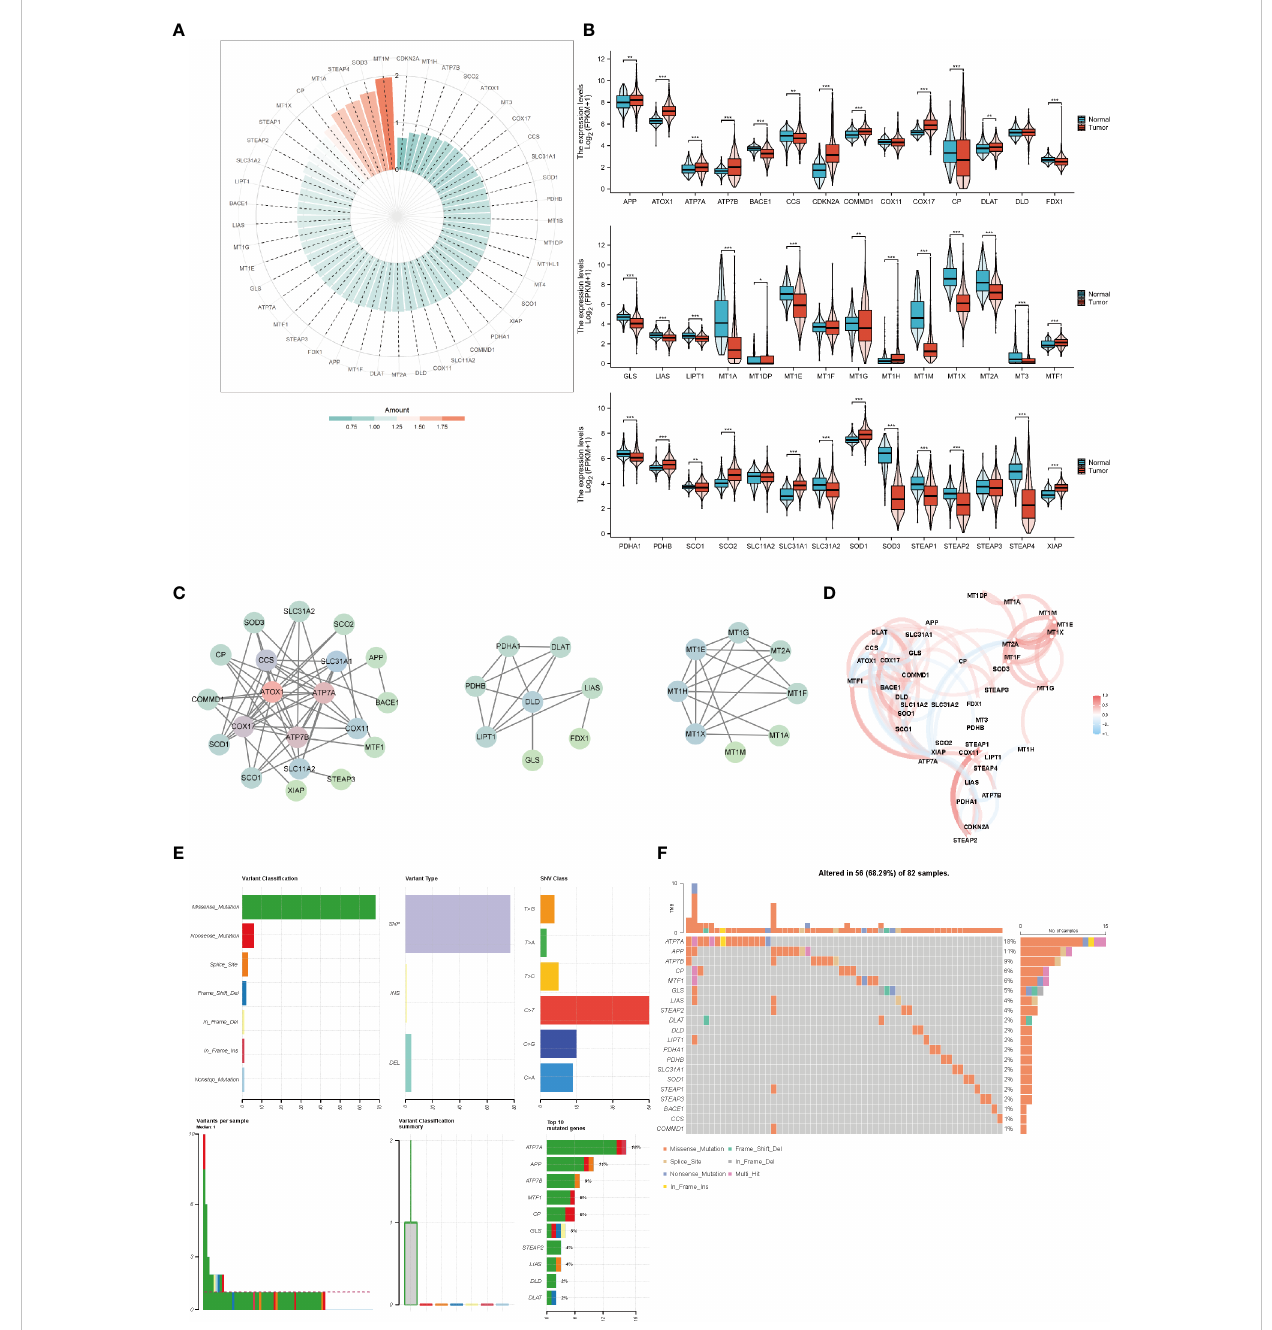
FIGURE 2 The expression and genetic variation of copper-related genes in breast cancer samples. Heatmap (A) and box plots (B) of differentially expressed copper-related genes in breast cancer samples. (C) PPI network of copper-related genes. (D) Correlation of copper-related genes in breast cancer samples. CNV, mutation frequency (E) and classi fi cation (F) of copper-related genes in breast cancer samples. ( *p < 0.05; **p < 0.01; ***p < 0.001